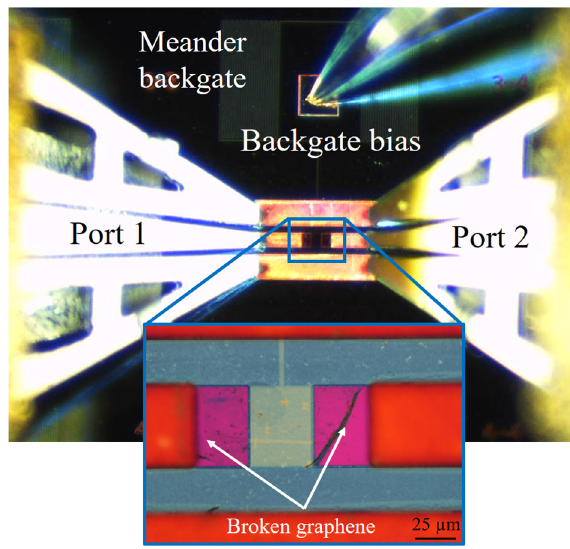
Figure 10. Fabricated device for graphene characterization.